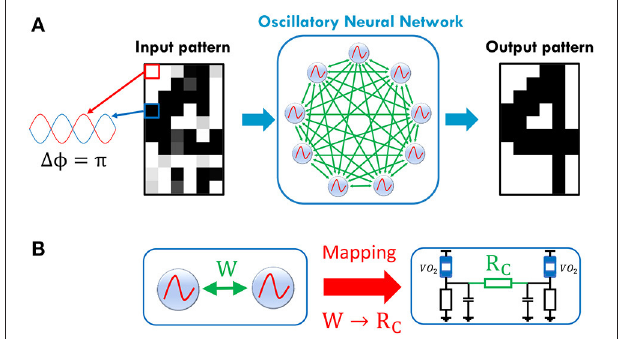
FIGURE 1 | (A) Illustration of ONN as a Hopfield Neural Network (HNN). HNN binary activations are translated in the phase relation between oscillators and a reference (here the first oscillator). ONN stores patterns via weights between the oscillators. Patterns can be retrieved if the input pattern is sufficiently close to the stored pattern. (B) The proposed mapping function to map any weight to a coupling resistance, facilitating large scale ONN